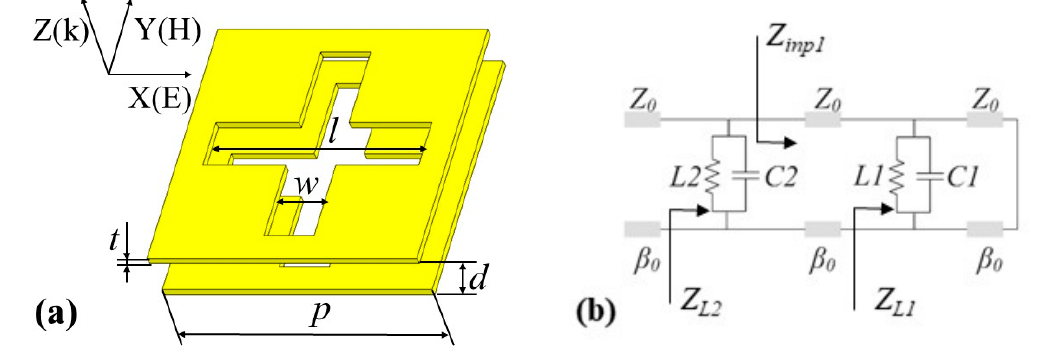
Figure 1. ( a ) Schematics of the double-layer cross frequency selective surface (FSS) unit structure. l , w , t , p , and d represent the arm length, arm width, thickness, period, and spacing of the double-layer FSS structure, respectively; ( b ) equivalent circuit model of the double FSS structure.